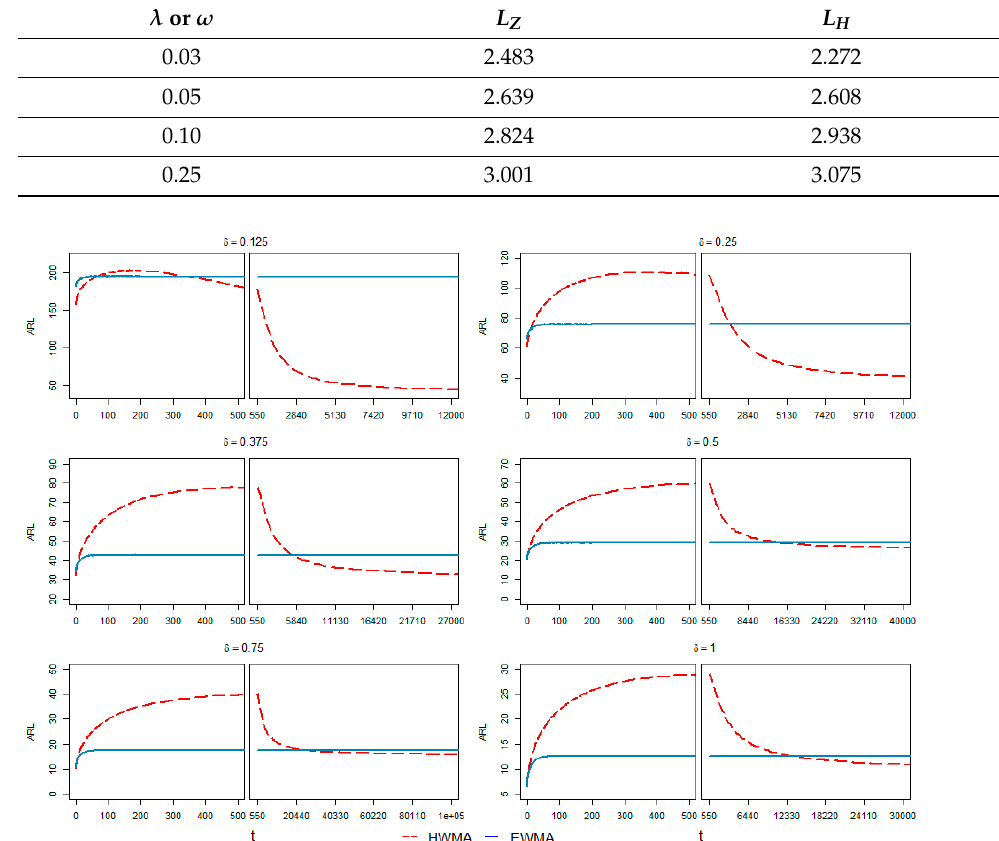
Figure 2. CED curves for the HWMA and EWMA charts under small to moderate shifts at λ = 0.03 with respect to time points ( t ) .